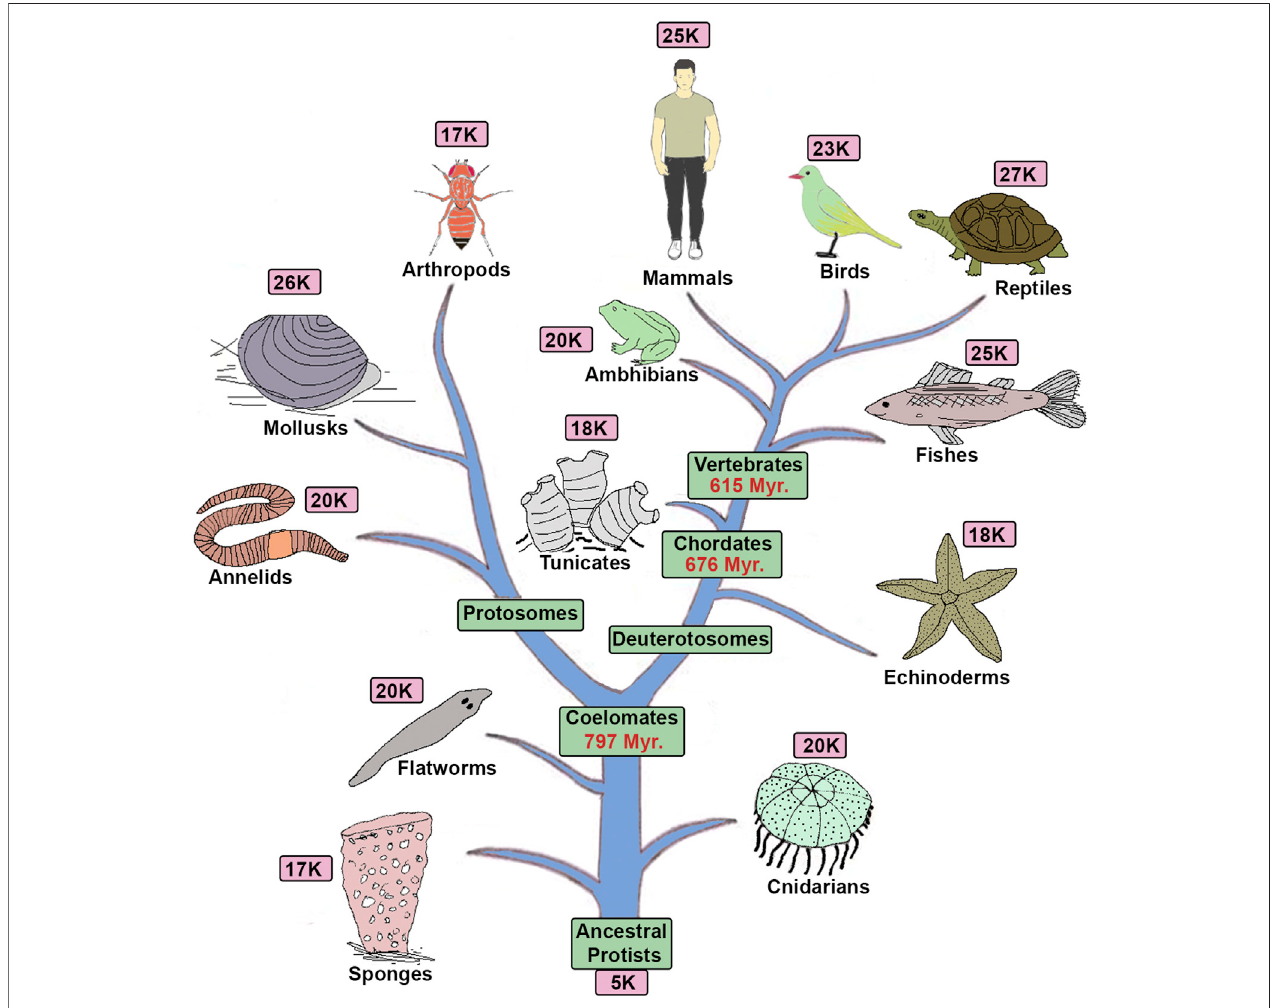
FIGURE 1 | Tree of life and gene complexity: The diagram shows a phylogenetic tree of animals with the approximate total number of genes present in each genome based on sequencing of their representative genomes (Hedges et al., 2015).